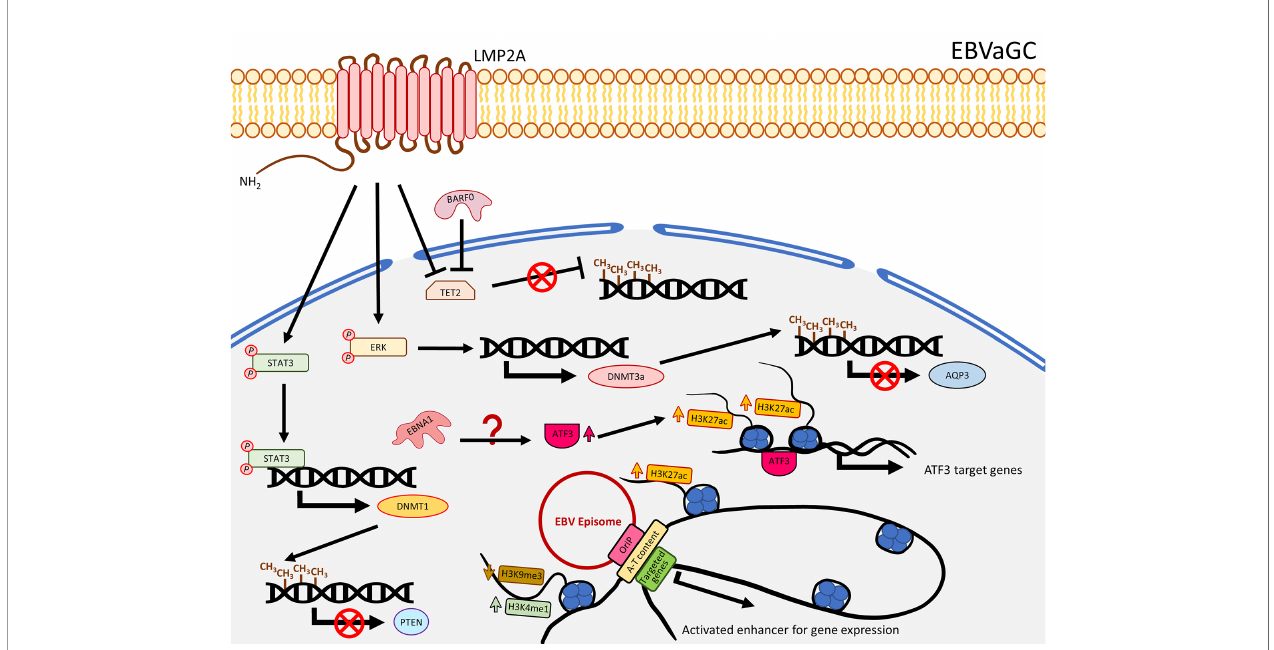
FIGURE 2 | A schematic diagram shows the impact of EBV on epigenetic dysregulation in EBVaGC. LMP2A inhibits TET2 and activates STAT3 and ERK signaling pathways to enhance expression of DNMTs, resulting in promoter DNA hypermethylation to suppress gene expression including PTEN and AQP3 . EBNA1 enhanced the expression of ATF3, which functions as a transcription factor, to promote target gene expression, characterized by gain of H3K27ac. EBV can also interact with the host genome, where A-T content is enriched as well as H3K4me1 and H3K27ac, and reduced H3K9me3 levels to promote gene